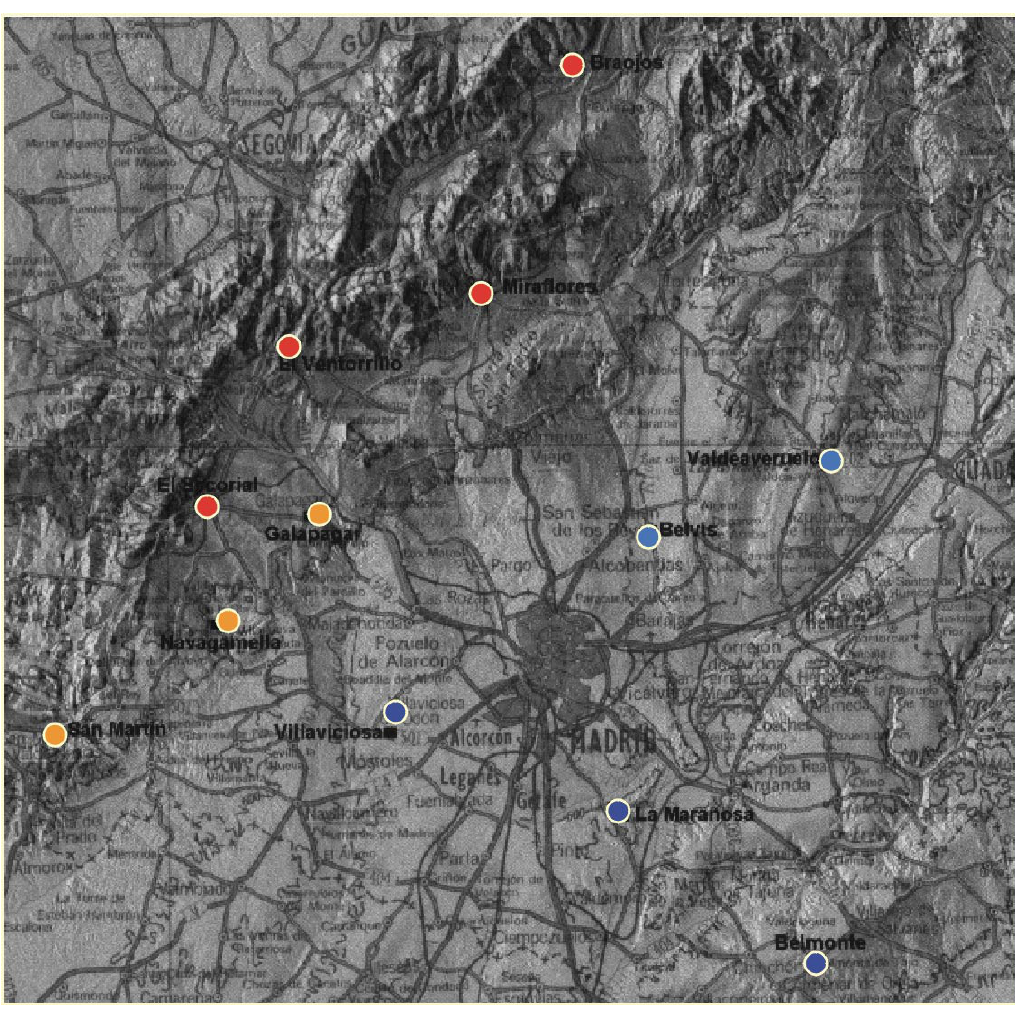
FIGURE 1. Map of the locations: Class I (red), Class II (orange), Class III (light blue), and Class IV